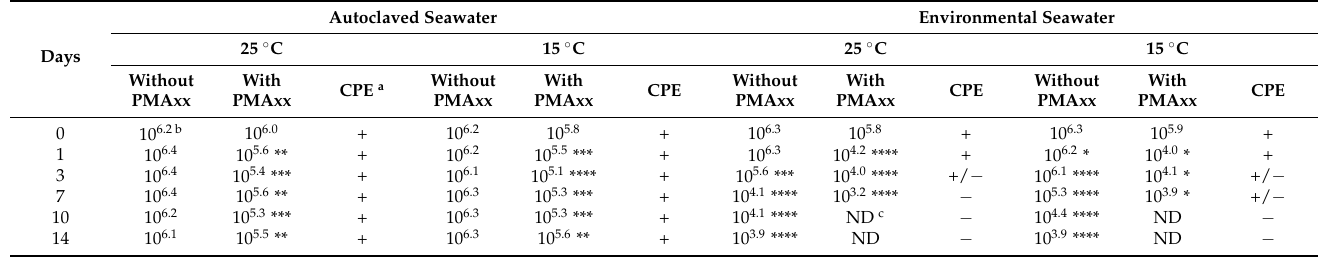
Figure 4. Changes in RSIV copy number under different marine environments. ( a ) Results of changes in RSIV viability in autoclaved seawater over time. ( b ) Results of changes in RSIV viability in environmental seawater over time. Error bars represent the standard deviation of the mean ( n = 3). The dotted line represents the detection limit. Asterisks indicate significant differences (* p < 0.05, ** p < 0.01, *** p < 0.001, **** p < 0.0001) compared with the control. Table 2. Results of RSIV qPCR, viability qPCR, and cell culture isolation under various seawater environments. Results represent the average of triplicates per assay.